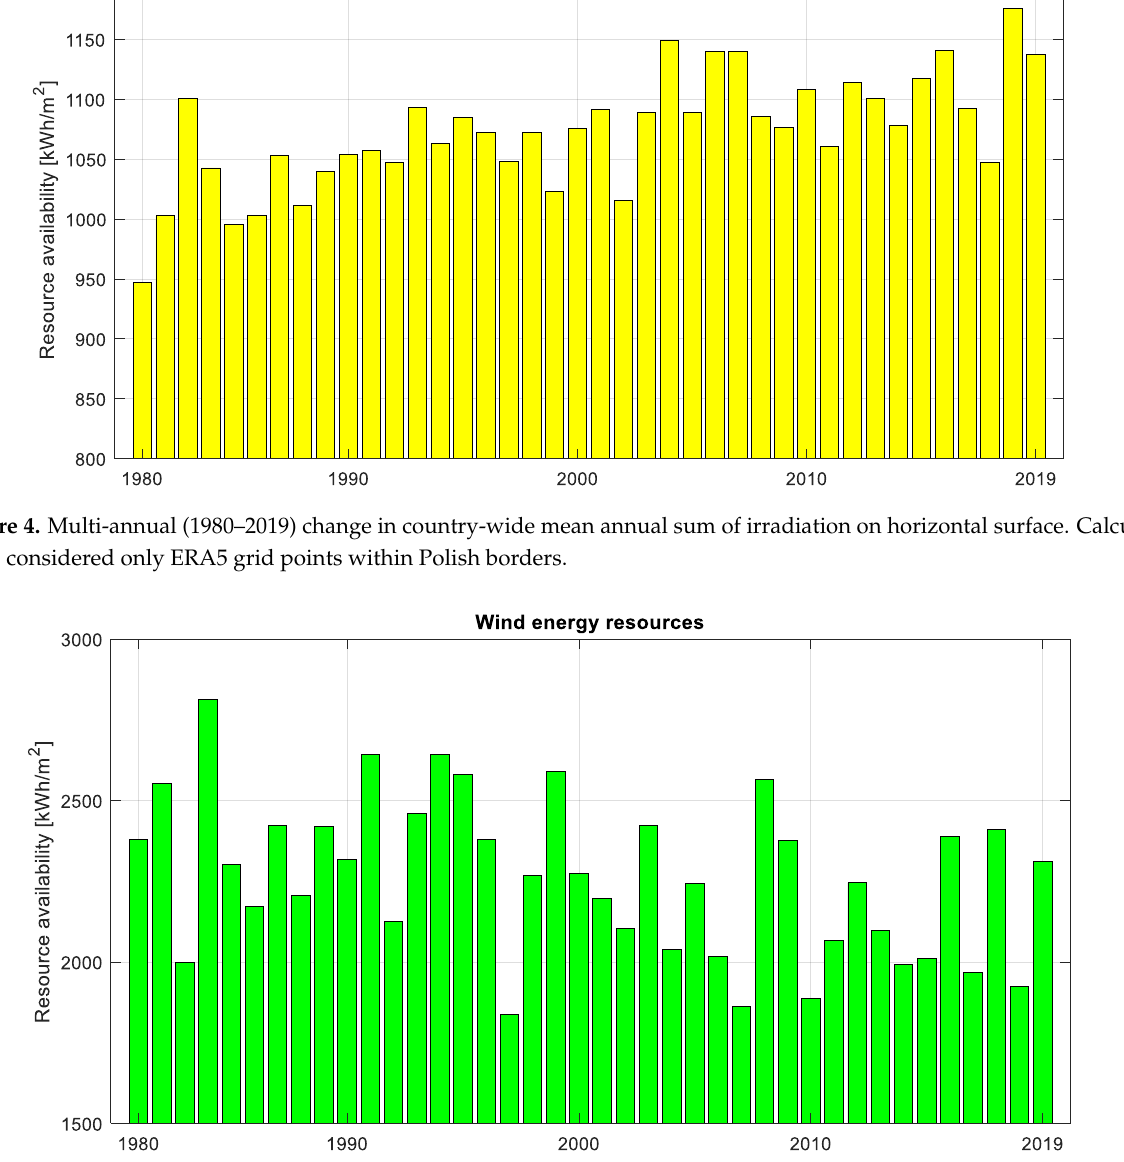
Figure 5. Multi-annual (1980–2019) change in country-wide mean annual sum of wind energy at 100 m a.g.l. Calculations considered only ERA5 grid points within Polish borders.